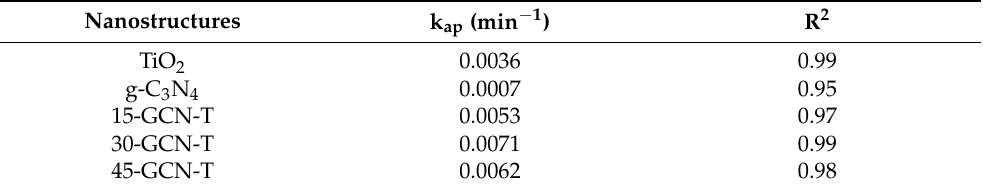
Table 2. Pseudo-first-order kinetic parameters (rate constants and linear regression coefficients) for the photocatalytic degradation of MO under solar simulating light in 4 h by TiO 2 , g-C 3 N 4 , 15-GCN-T, 30-GCN-T and 45-GCN-T nanostructures.